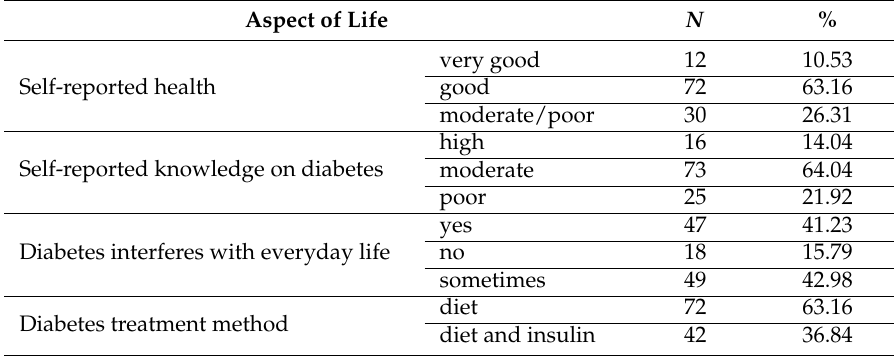
Table 2. Influence of diabetes on various aspects of the respondents’